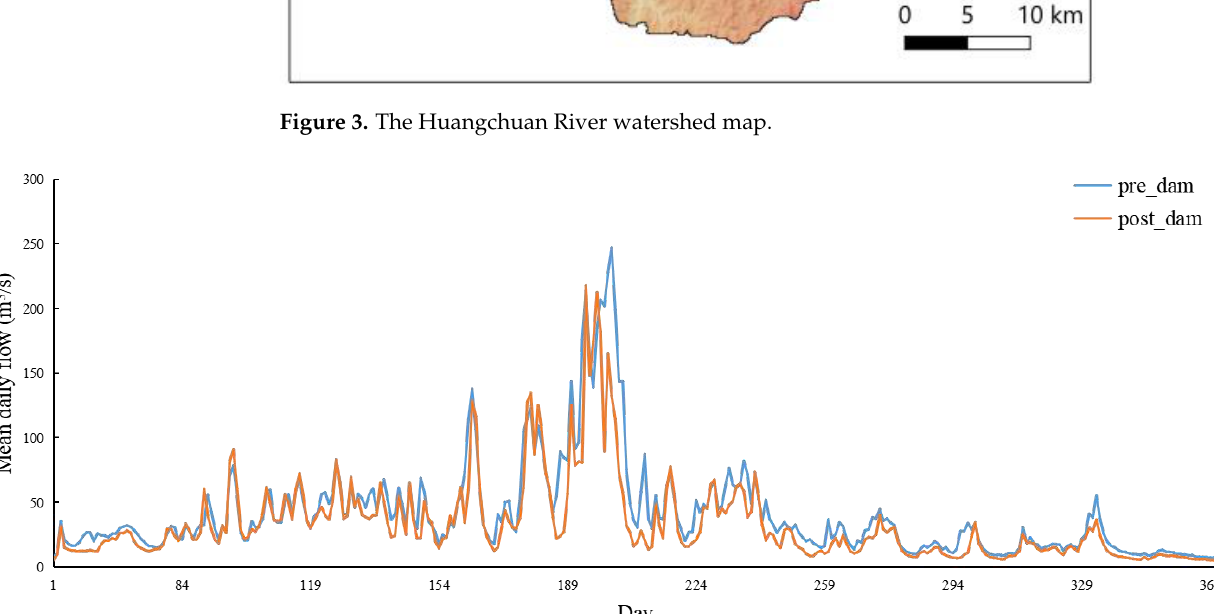
Figure 4. Mean daily flow duration curve in pre_dam and post_dam periods.